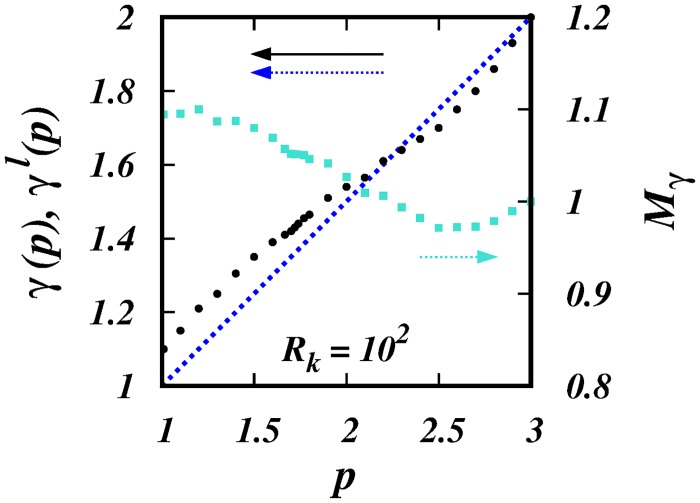
γ(p), γl(p), and Mγ(p) against p for Rk = 102.The black filled circles are the γ(p)’s from the simulations. The dotted blue line is the locality scaling γl(p) = (1 + p)/2. The cyan squares are the ratios, Mγ = γ(p)/γl(p) (right hand scale). See Table 2.